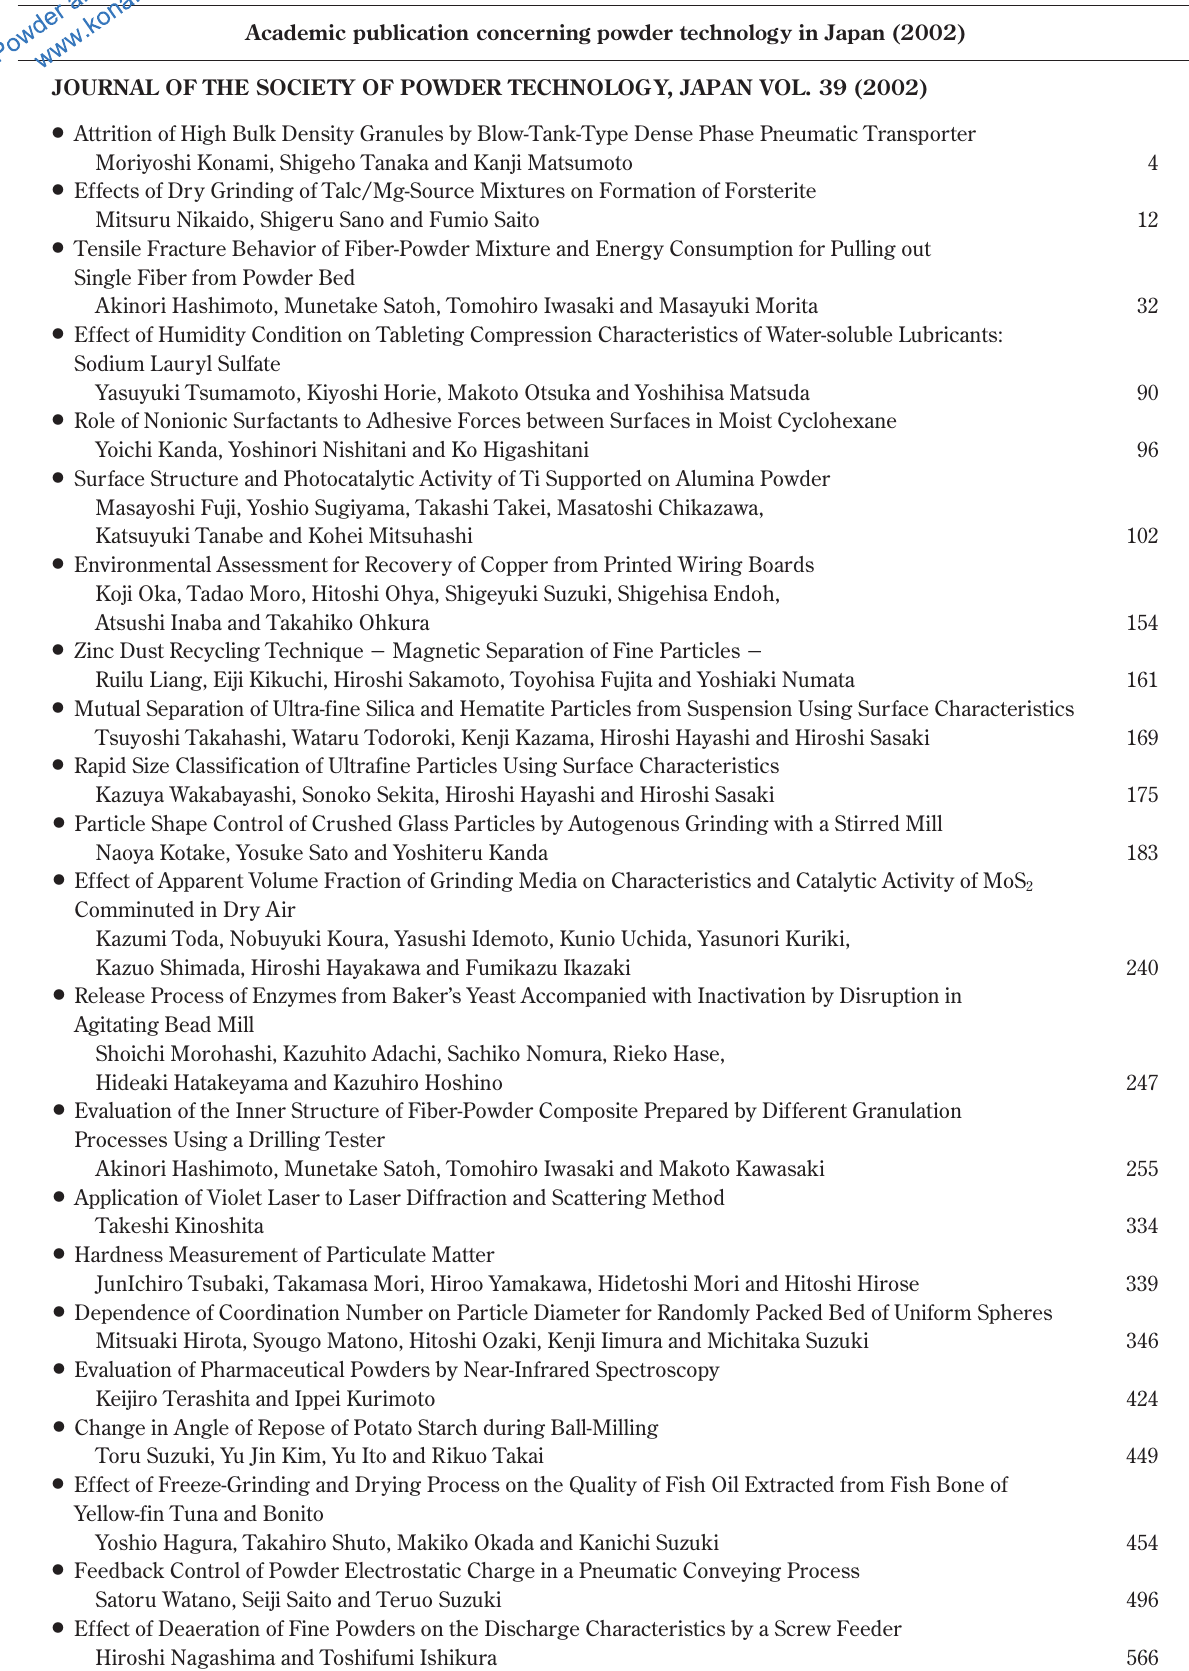
339 346 424 449